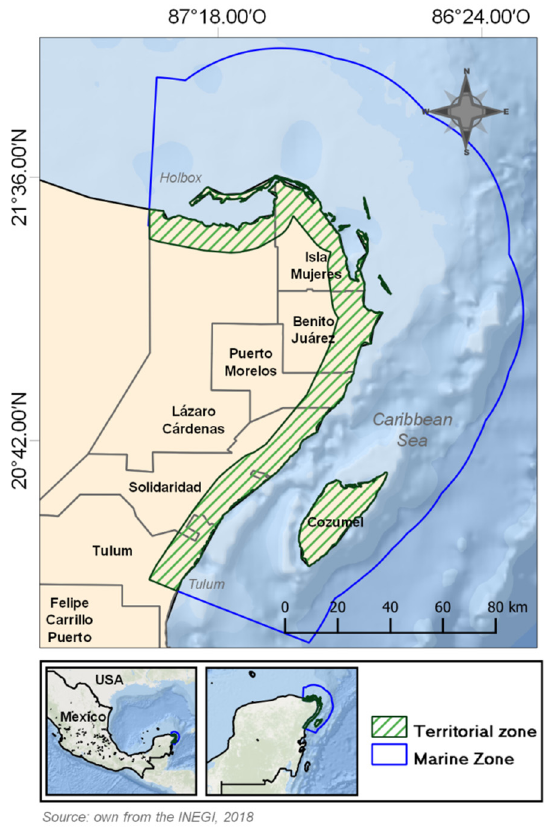
Figure 1. Study Area.